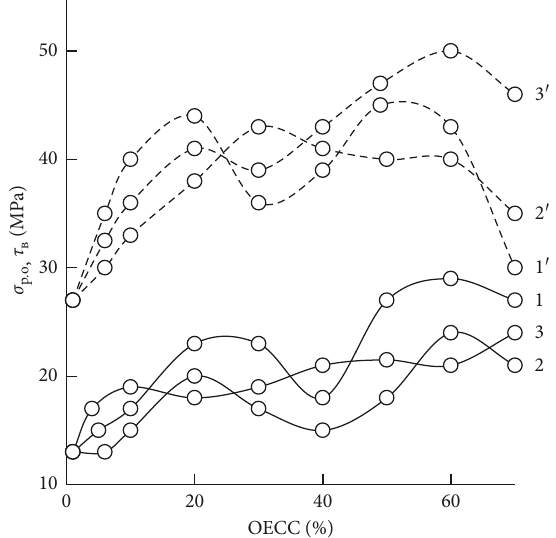
Figure 9: Dependence of the adhesive properties of the ED-20 +OECC +DETA compositions on the concentration and modifier type: DCC/UP-675 (1,